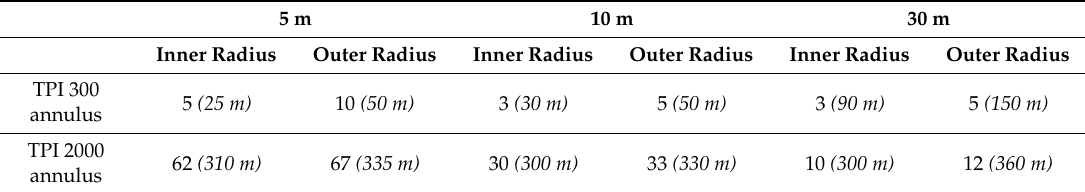
Table 3. Parameters of the moving window sizes in pixels (px) used in this approach for the three different pixel resolutions. Cell sizes in meters are shown in